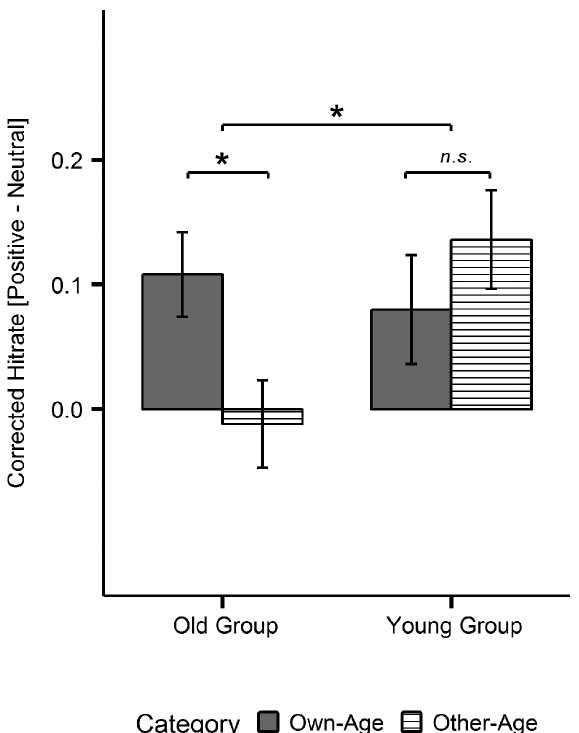
Figure 8. Post-hoc memory results for the three-way interac- tion between emotion, image category and age-group. Differ- ence between corrected hit rates for positive minus neutral own-age and other-age stimuli, plotted separately for each age-group. Error bars represent standard errors of the mean. * p , .05, n.s. =not significant.